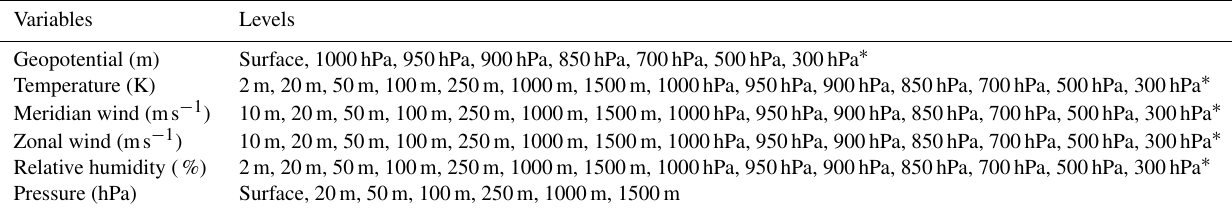
Figure 3. Illustration of the ideal representation of a real mountain area (massif des Grandes Rousses, a ) as topographic classes (b) in the S2M reanalysis. Table 1. List of variables and levels used as meteorological guess. All levels are not always available depending on the period and the grid point (asterisks indicate a level available only in the ERA-40